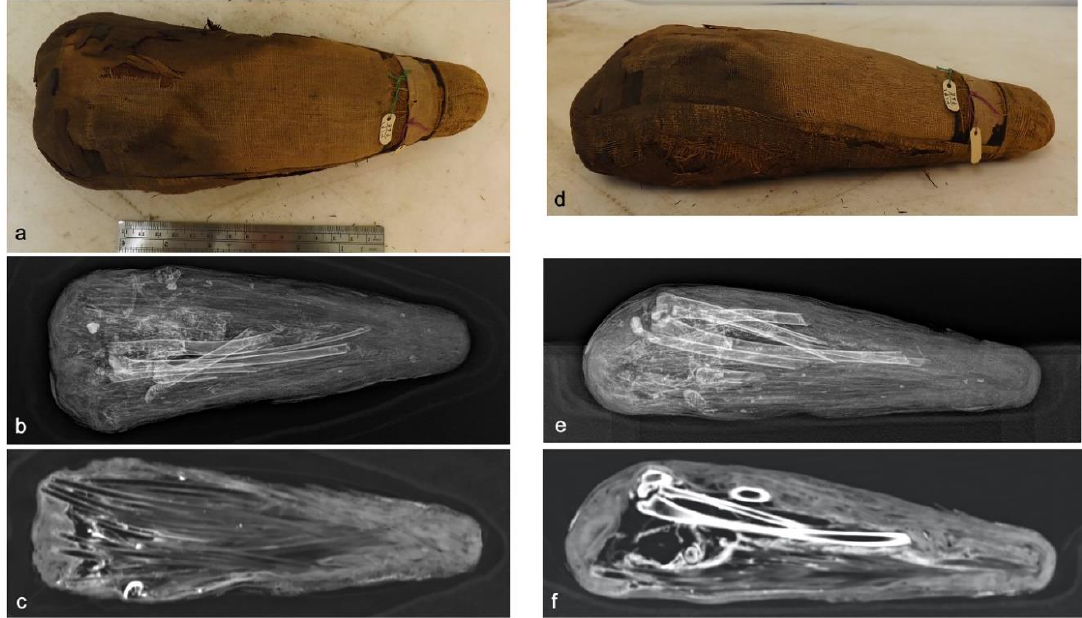
Figure 8. Figure highlighting the incomplete skeletal remains contained within mummy MFA acc. no. 6254. Images ( a ) anterior posterior photograph, ( b ) anterior posterior radiograph, ( c ) coronal CT reformat showing the arrangement of feather shafts, visible as air-filled linear structures, ( d ) lateral photograph, ( e ) lateral radiograph, and ( f ) sagittal CT reformat showing the incomplete skeletal elements with feathers underneath. [Photographs and radiographs created by author for the Ancient Egyptian Animal Bio Bank.].